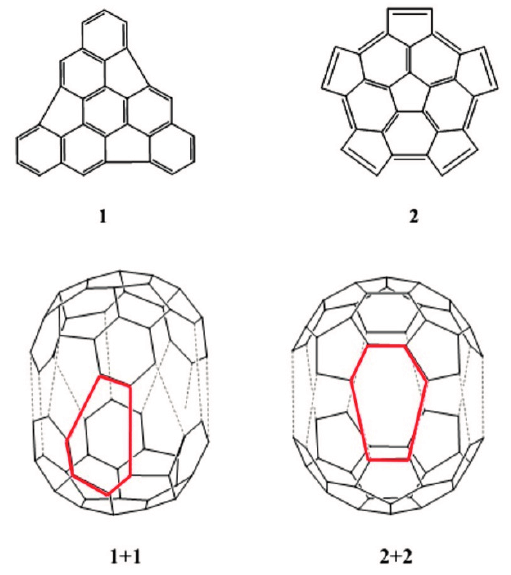
Figure 1. Triindenetriphenylene (fragment 1 ) and pentacyclopentacorannulene (fragment 2 ), and the approaching of two triindenetriphenylene fragments, 1+1 , and two pentacyclopentacorannulene fragments, 2+2 , to form C 60